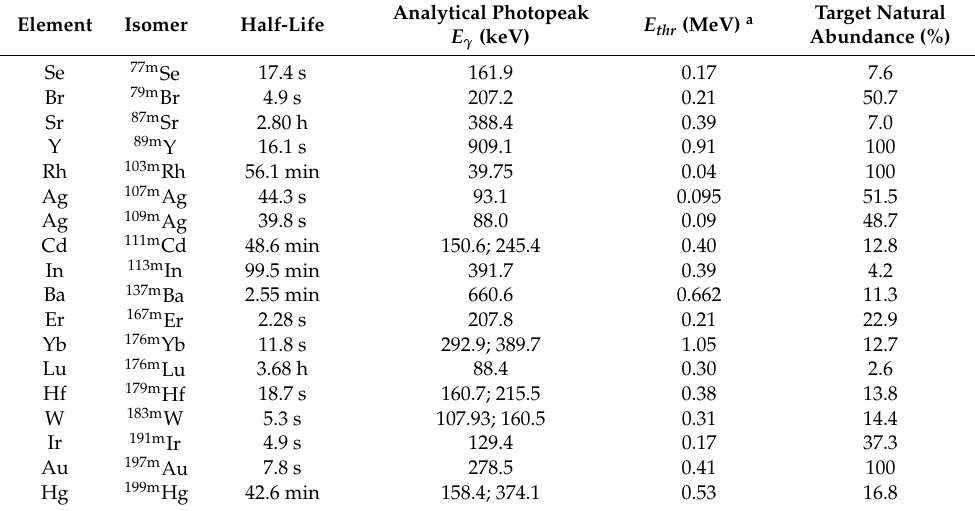
Table 7. Main short-lived products of photoexcitation reactions ( γ , γ (cid:48) ) [15]. Element